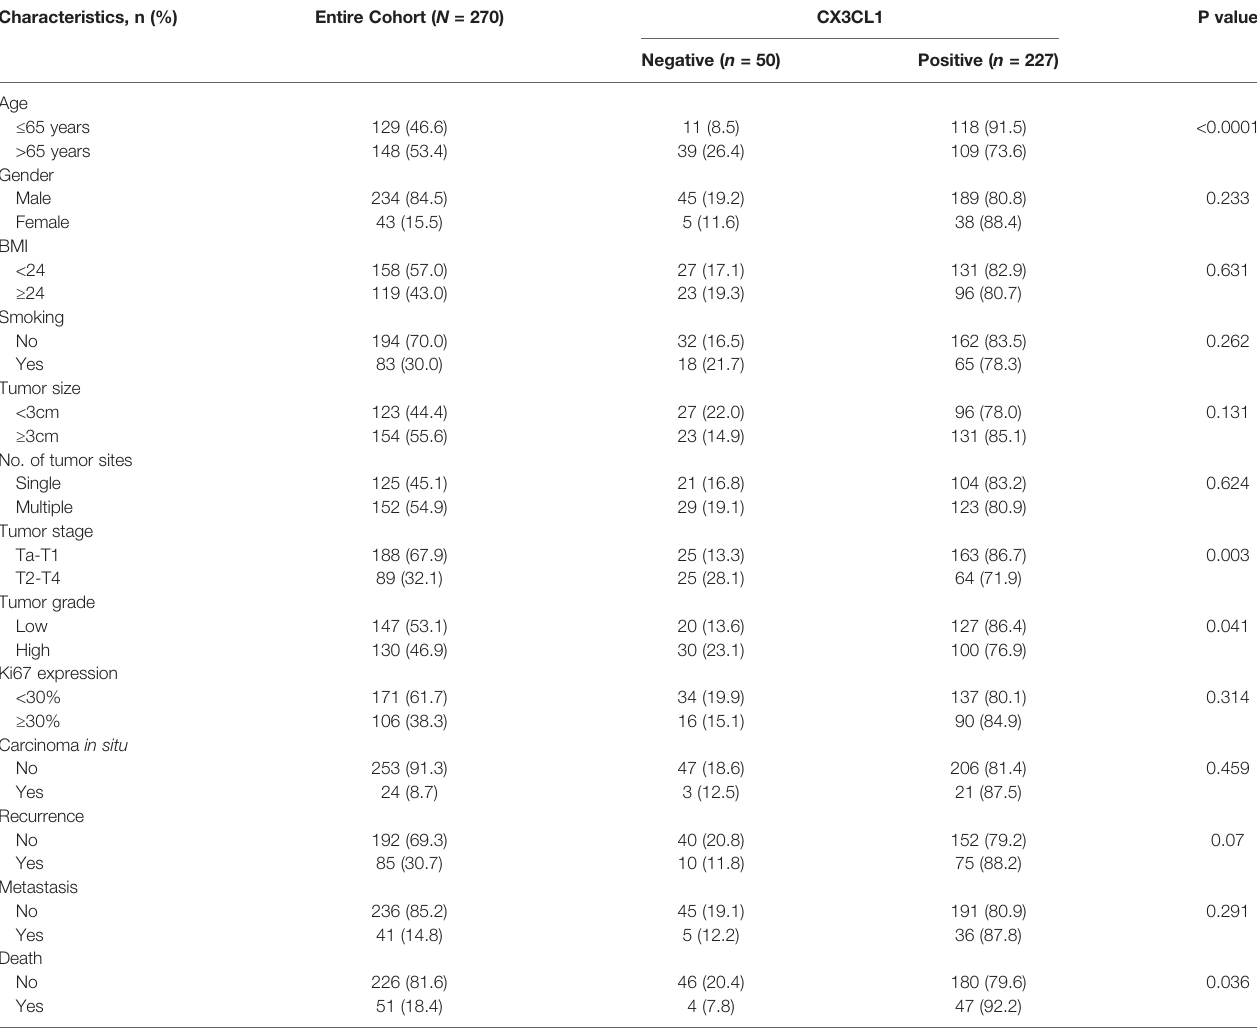
TABLE 1 | Clinical characteristics of entire cohort and subgroups by CX3CL1 expression. Characteristics, n